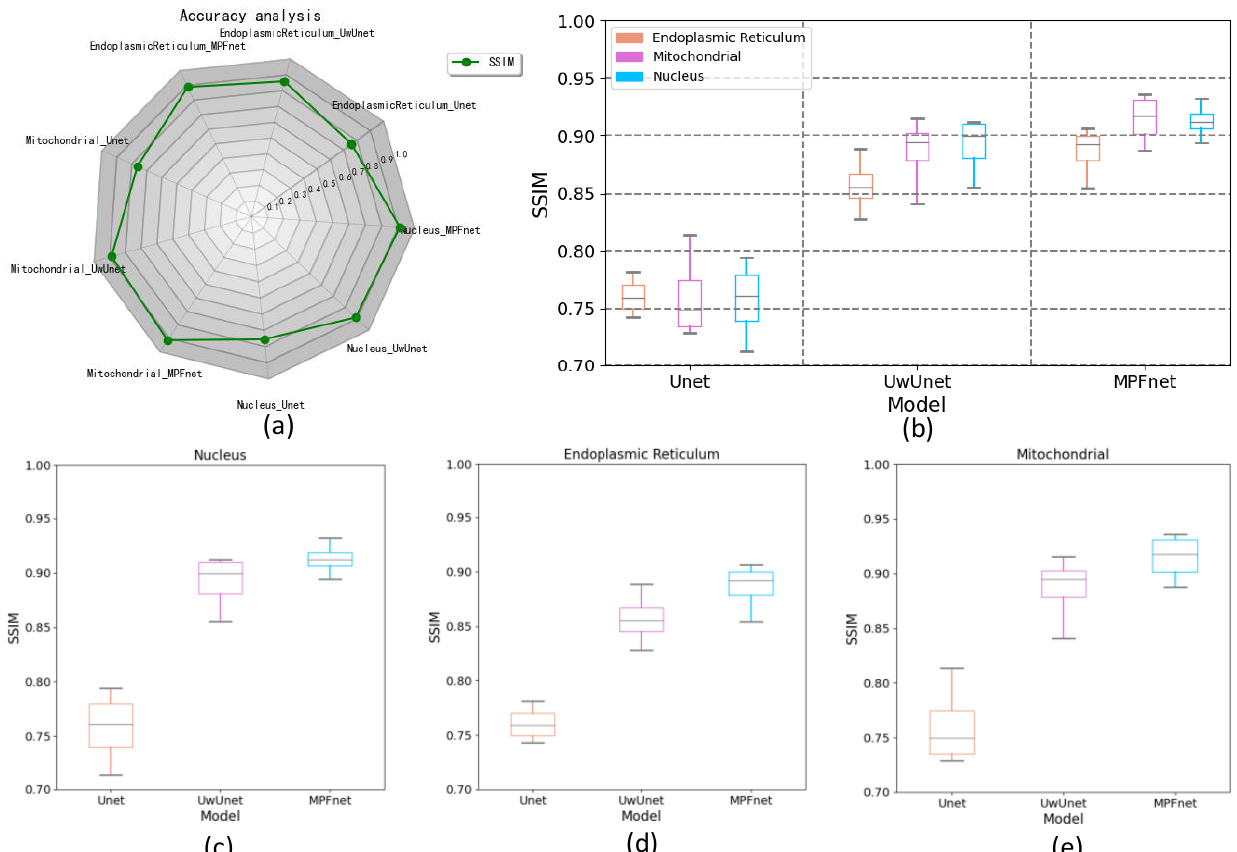
Figure 9. Comparing SSIM performance among various prediction algorithms. ( a ) The SSIM performance measures typical of predictive tasks. ( b ) Box plot of SSIM values in all organelle (nuclei, mitochondria, and endoplasmic reticulum) prediction task sets with the MPFnet-based learning model and compared with that of varied deep neural network-based prediction models such as Unet and UwUnet. Box plot of SSIM values on ( c ) nuclei, ( d ) endoplasmic reticulum, and ( e ) mitochondria prediction task sets with MPFnet-based learning model and compared with that of varied deep neural network-based prediction models such as Unet and UwUnet learning model.